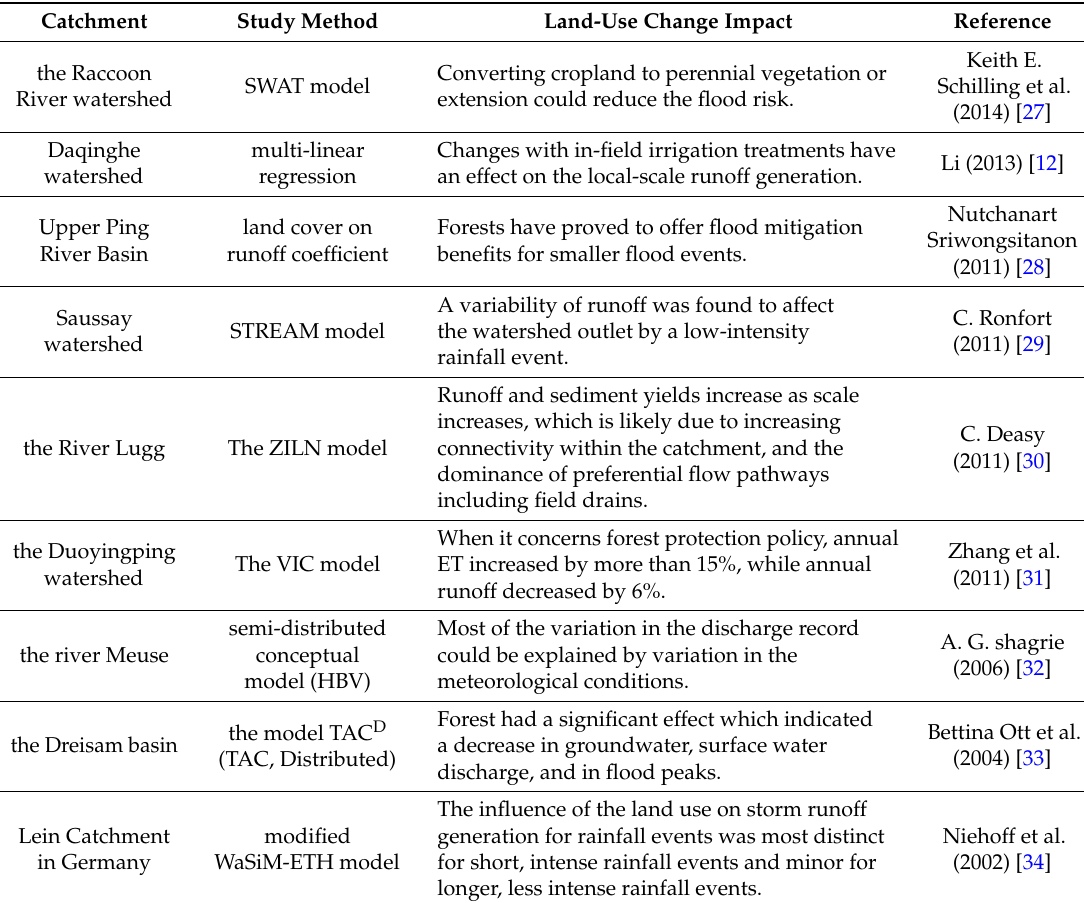
Table 1. The studies on the land use